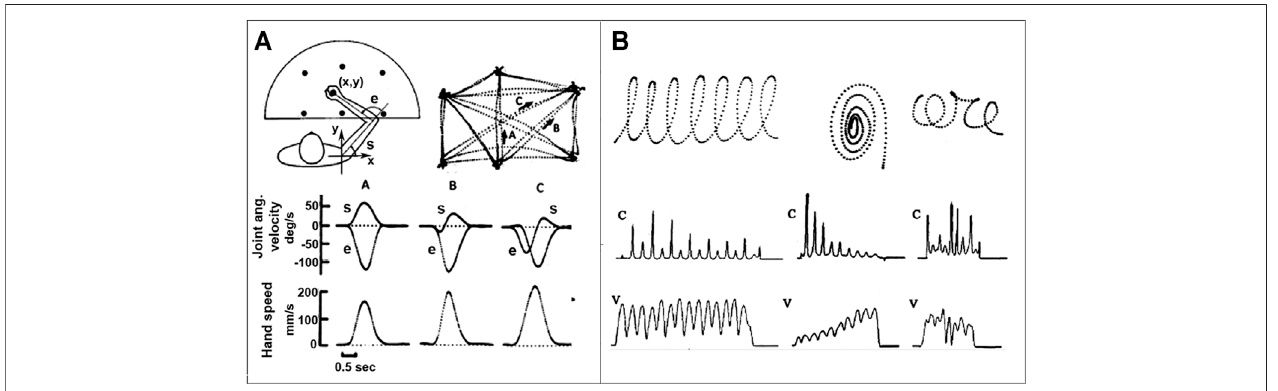
FIGURE 1 | Spatio-temporal invariants in trajectory formation. Panel (A) : Planar reaching movements between six target points; A, B, and C correspond to three movement examples, characterized by the joint rotation patterns and the corresponding speed pro fi les of the joints and the hand; note the invariant bell-shaped speed pro fi les. Panel (B) : Three examples of continuous hand scribbles displayed as digitized trajectories, including the pro fi les of the velocity (V) and curvature (C); note the anti-correlation of the two pro fi